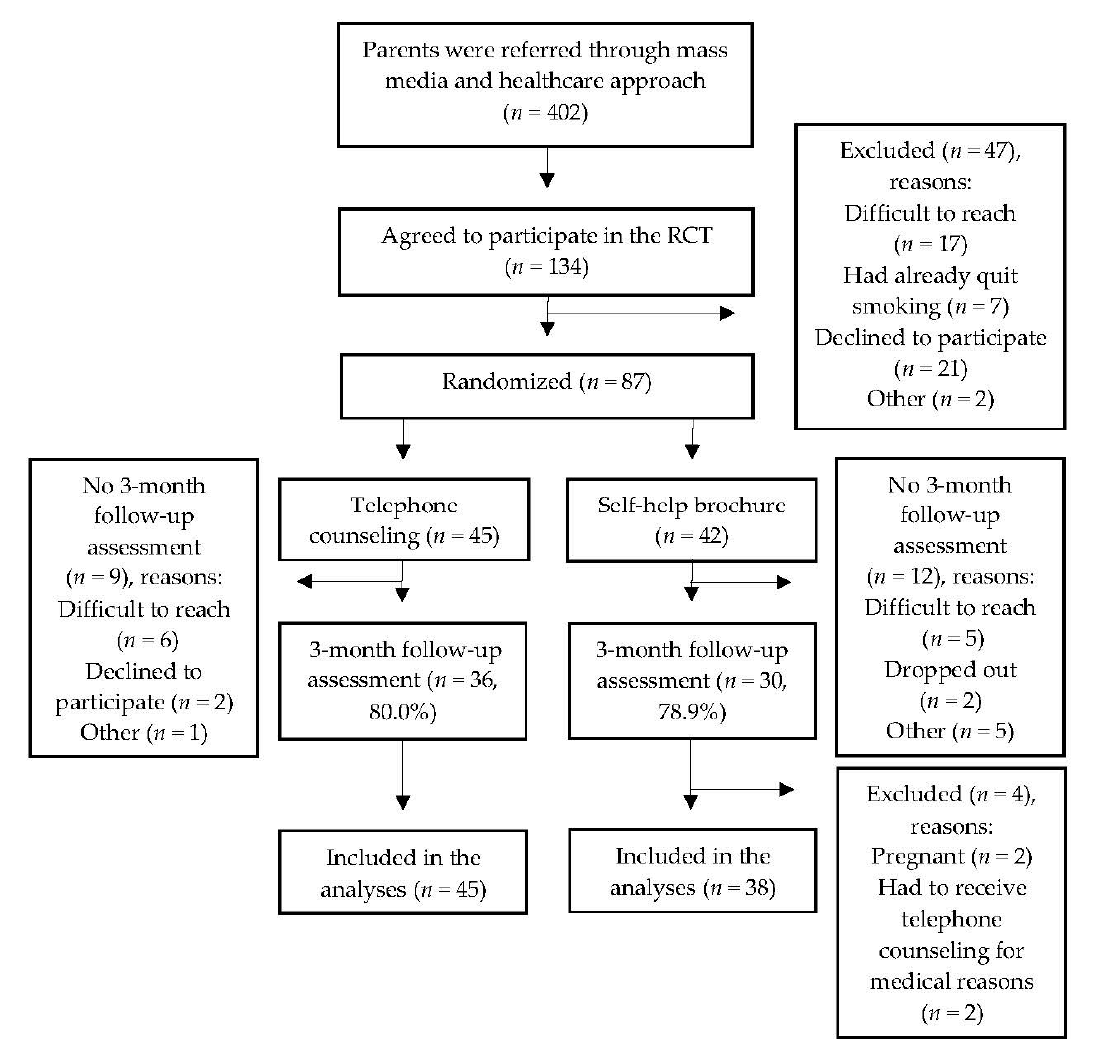
Figure 1. Flowchart of recruitment and data collection.